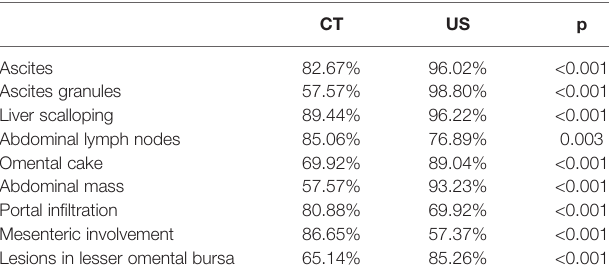
TABLE 2 | The diagnostic accuracy of US and CT with surgery as the gold